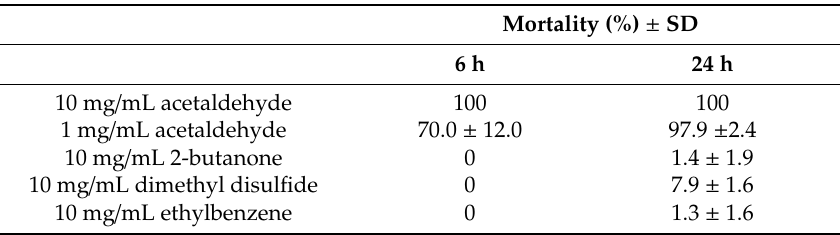
Figure 3. Morphological variations in M. incognita J2s after acetaldehyde and dimethyl disulfide treatments. ( A ) Treated with H 2 O for 24 h; ( B ) treated with 10 mg/mL acetaldehyde for 24 h; ( C ) treated with 0.3% Tween 20 for 24 h; ( D ) treated with 10 mg/mL dimethyl disulfide for 24 h. Table 3. Fumigant activity of VOCs against M. incognita Table 2. Contact nematicidal activity of the VOCs against M. incognita.